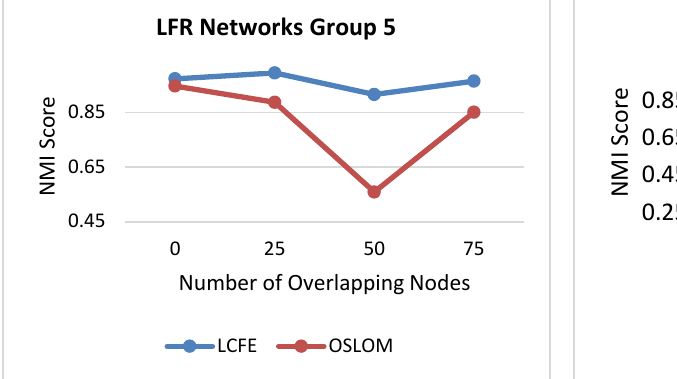
Fig. 5. NMI score comparison for LCFE and OSLOM for third group of LFR Networks with number of overlapping nodes ranging from 0 to 75